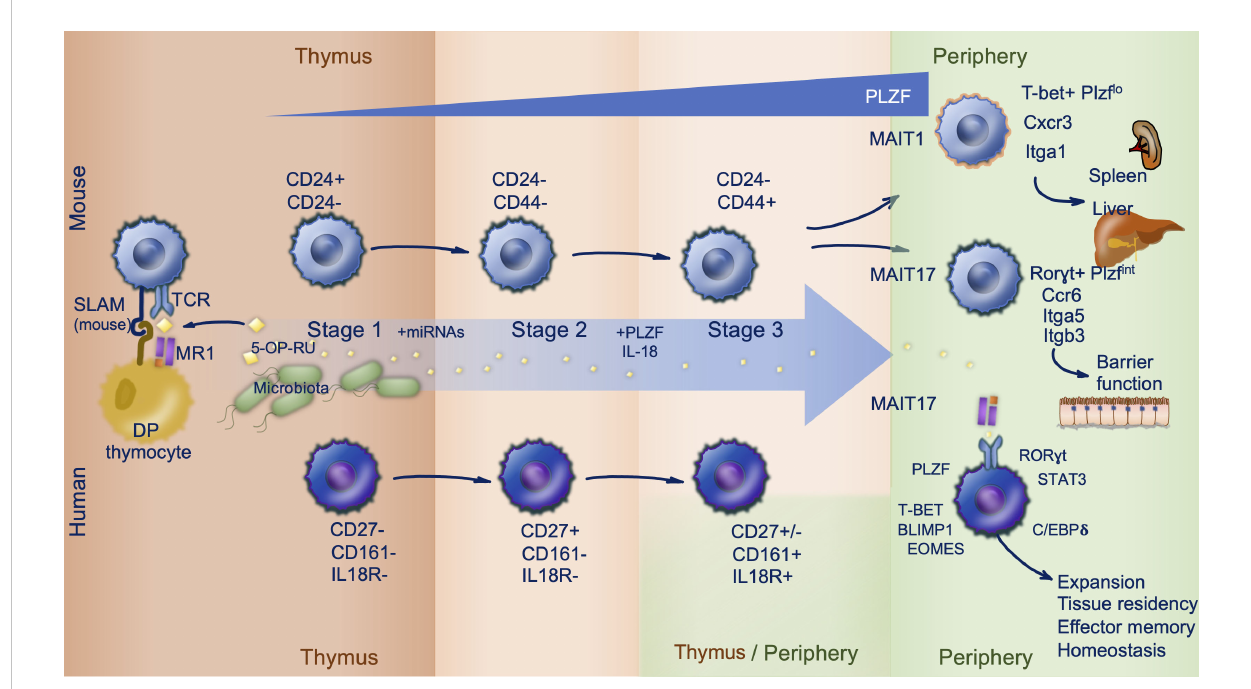
FIGURE 1 MAIT cell ontogeny. Mouse (top) and human (bottom) mucosal associated invariant T (MAIT) cell development follows three stages, largely within the thymus. Microbially derived 5-OP-RU is traf fi cked to the thymus and loaded onto MR1 expressed on double positive (DP) thymocytes. MAIT cells are subsequently positively selected on DP thymocytes in a process reliant upon signaling lymphocytic activation molecule (SLAM) interactions in mice (stage 1). During stage 2 and 3 MAIT cells acquire effector functions and their prototypic phenotype driven by PLZF expression. This occurs intrathymically in mice, but in human stage 3 can also occur peripherally. Distinguishing markers and important co-factors regulating differentiation are